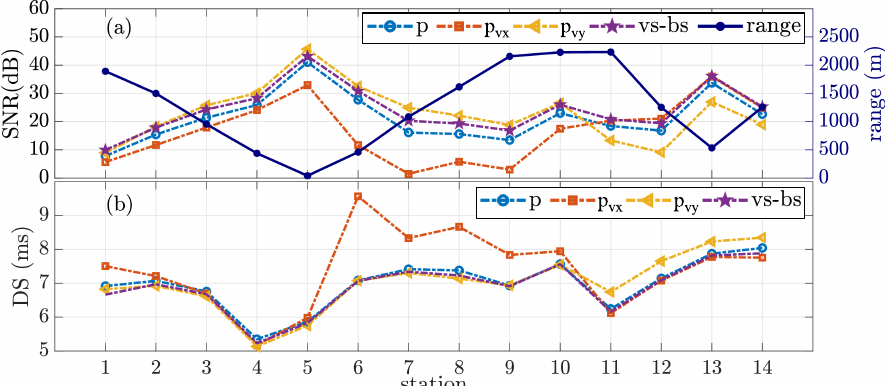
Figure 8. Estimated SNR ( a ) and RMS delay spread ( b ) along stations for pressure ( p ), directional components ( p vx and p vy ), and for vector sensor beam steering method (vs-bs).